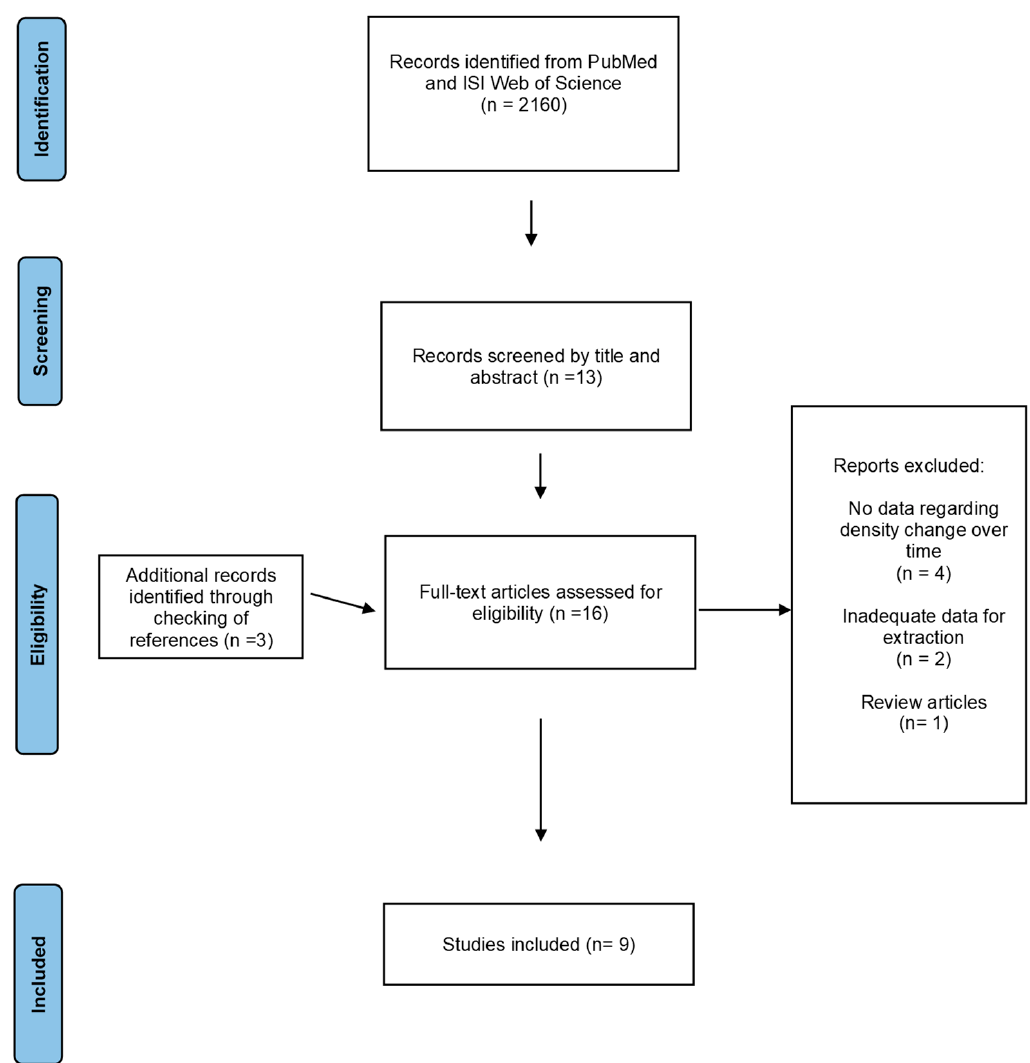
Figure 1. Flowchart of the study selection process.